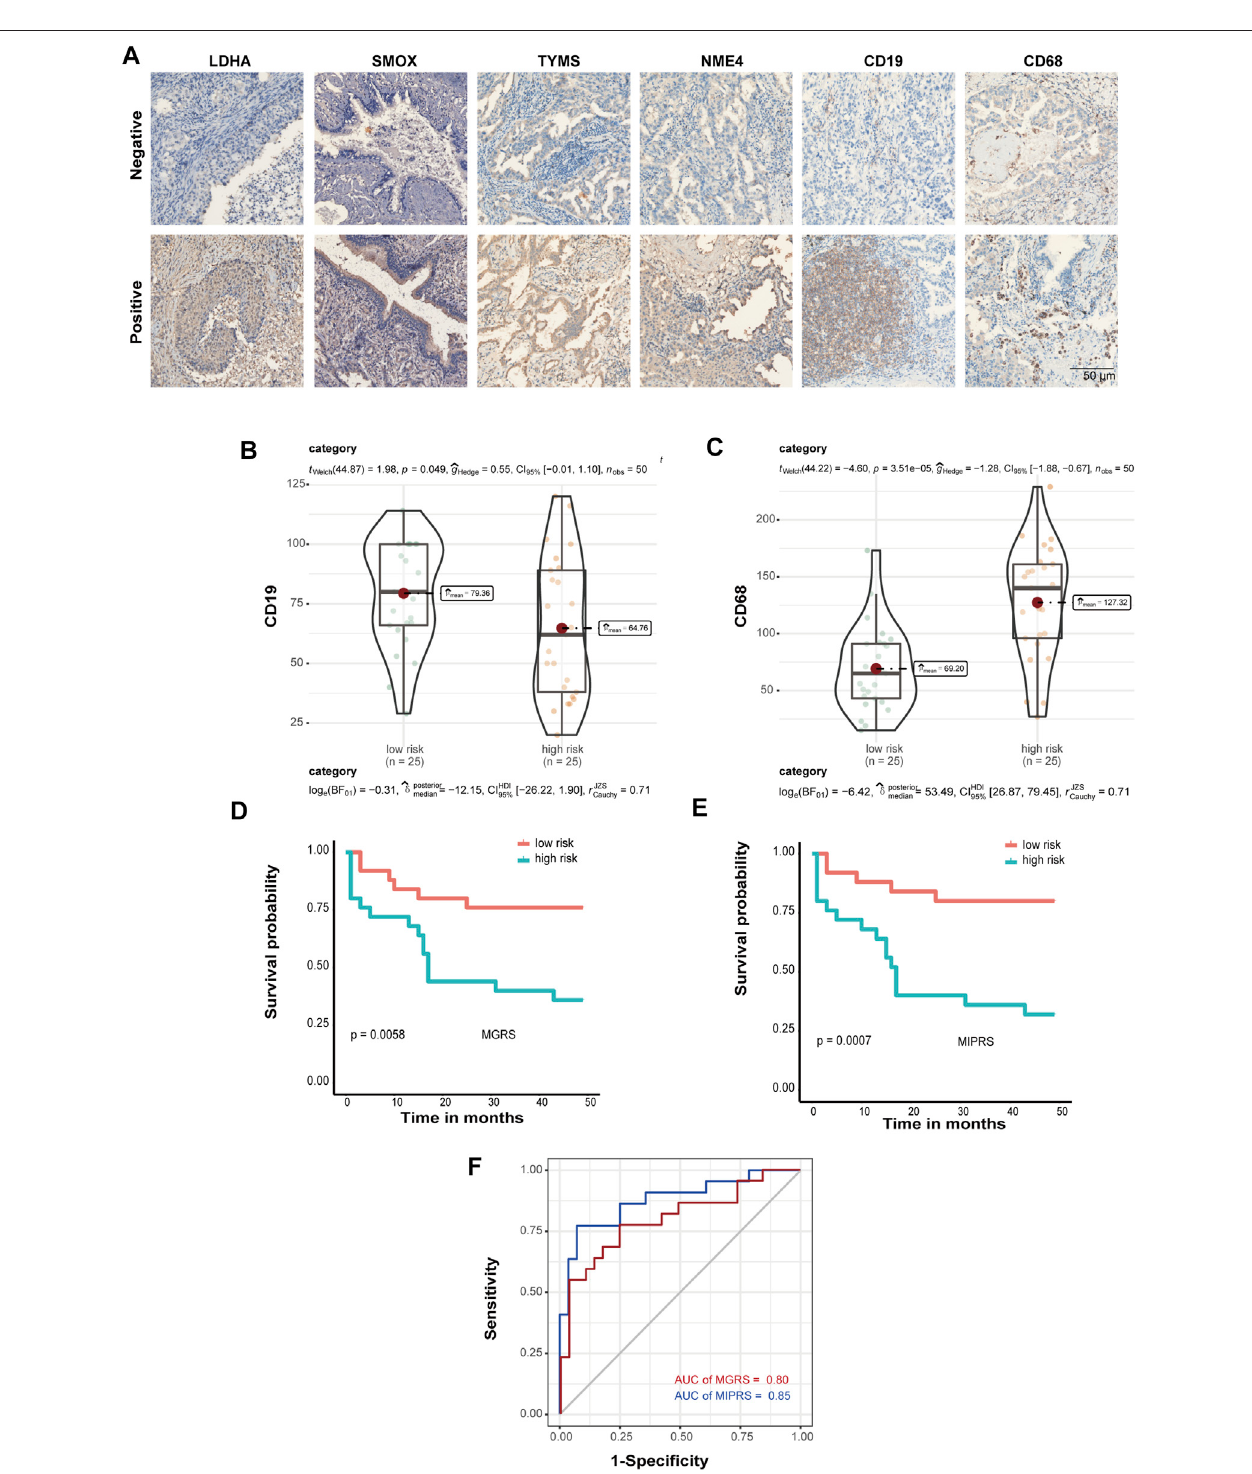
FIGURE 6 | Prediction model optimization based on immunohistochemistry. (A) The representative IHC positive and negative images of four prognostic proteins, aswellasmarkersofBcells(CD19)andmacrophages(CD68).Box/violinplotshowingthattheexpressionofCD19 (B) andCD68 (C) wassigni fi cantlycorrelatedwiththe risk score. (D,E) Kaplan-Meier curves of the prediction model. The original model (D) and the optimized model (E) are shown. (F) ROC curves of the original model and the optimized model.